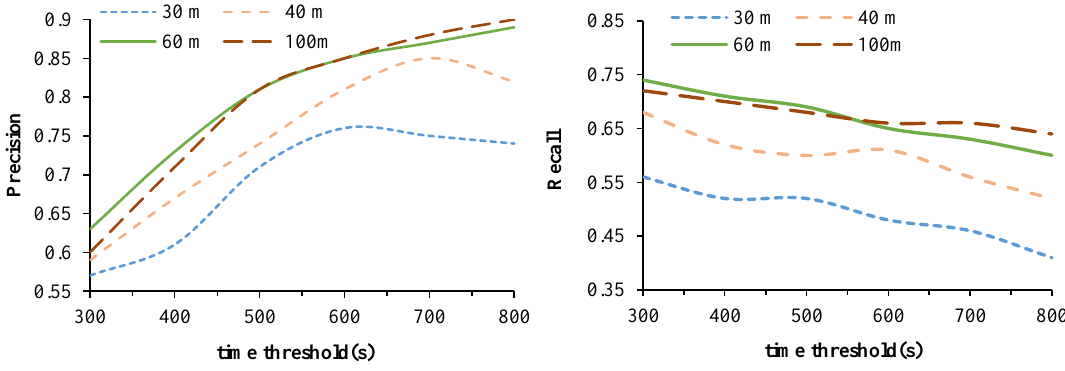
Figure 8. The precision and recall for different distance and time thresholds.